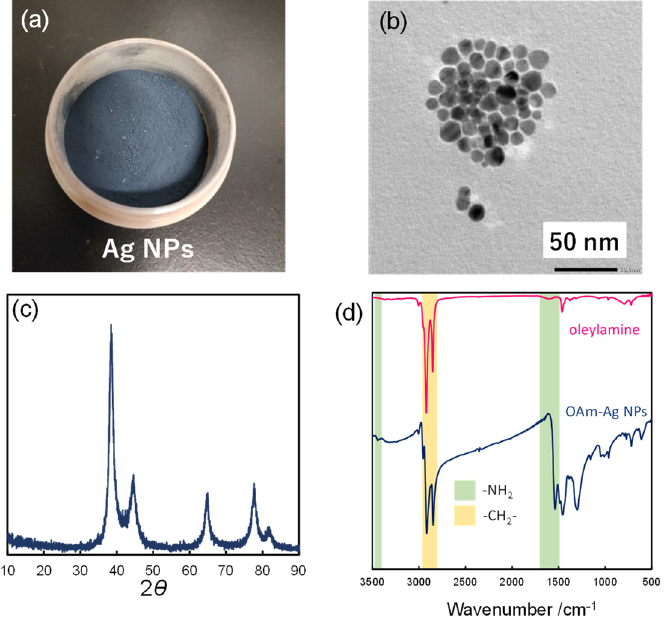
Figure 2. ( a ) OAm-Ag NP powder; ( b ) TEM image of OAm-Ag NPs; ( c ) XRD pattern of OAm-Ag NP powder; and ( d ) FT-IR spectrum of OAm-Ag NPs.